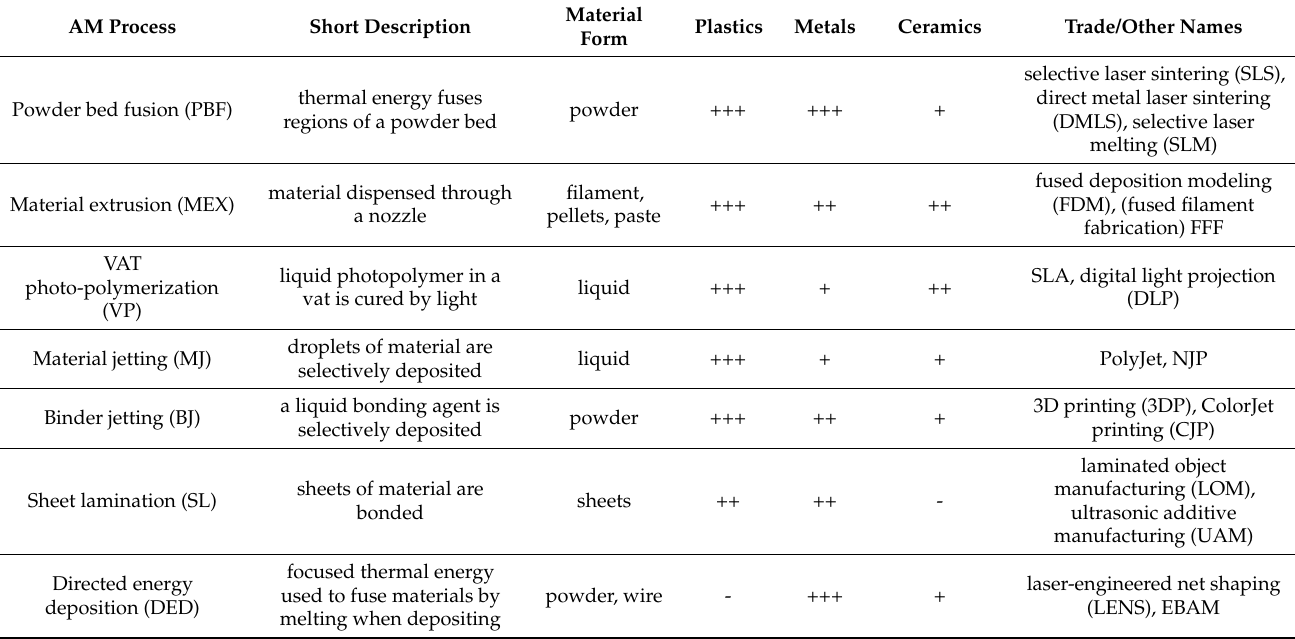
Table 2. Characteristics of different AM